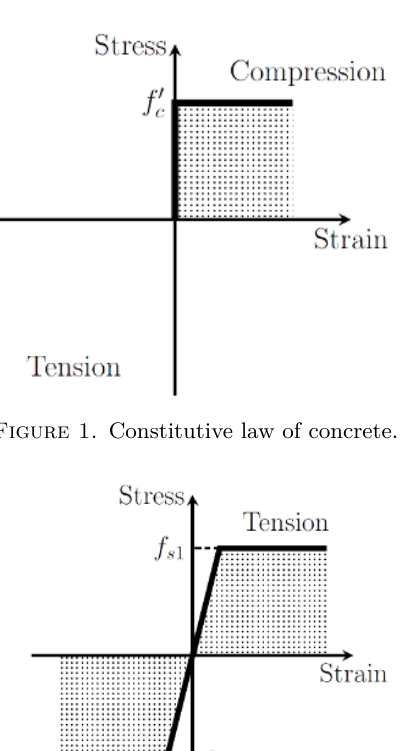
Figure 4. Critical crack